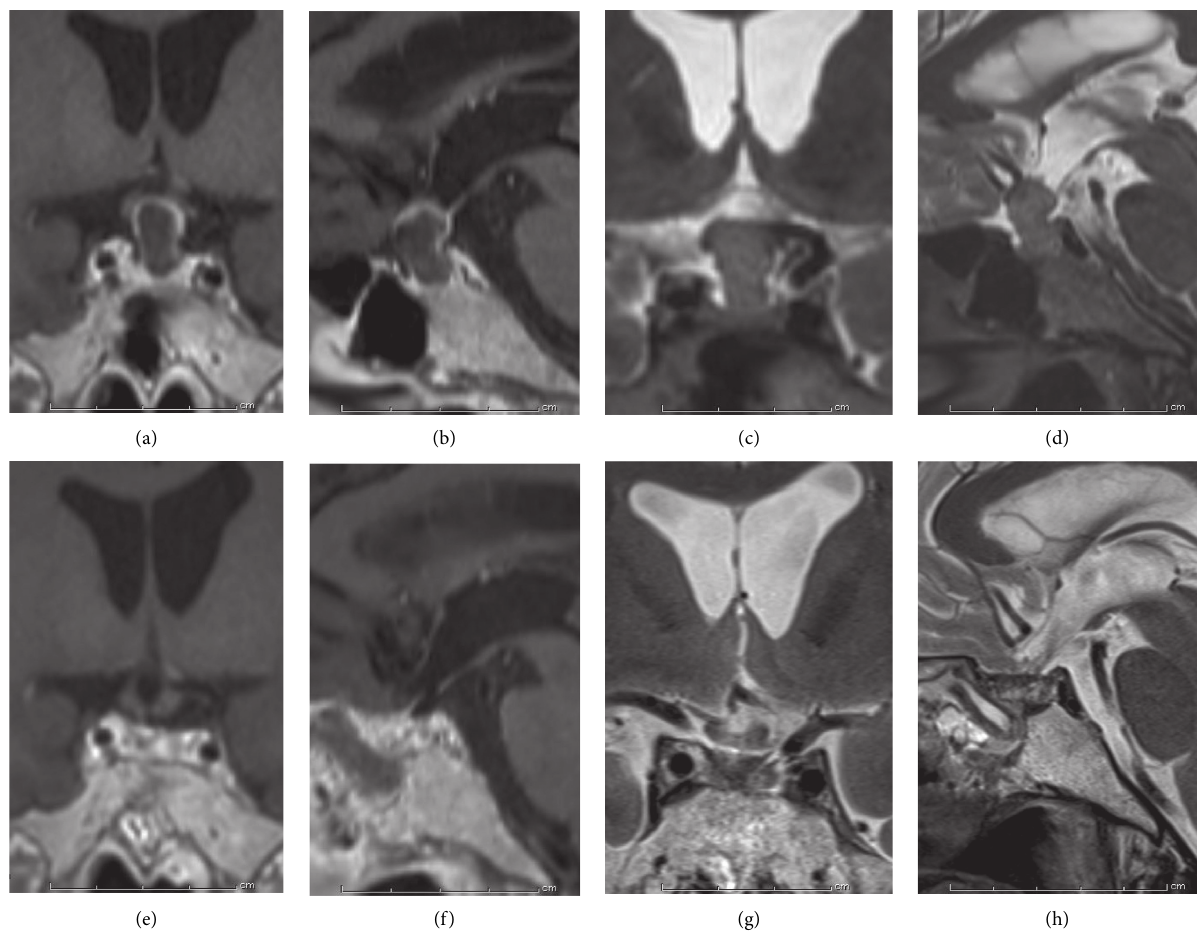
Figure 4: The displaced optic chiasm (a, b, c, and d) is successfully decompressed, and the cyst is totally resected (e, f, g, and h) on MR imaging at 4 months (19 weeks) weeks after surgery. Table 1: Characteristics of previous and current case reports of pituitary stalk epidermoid